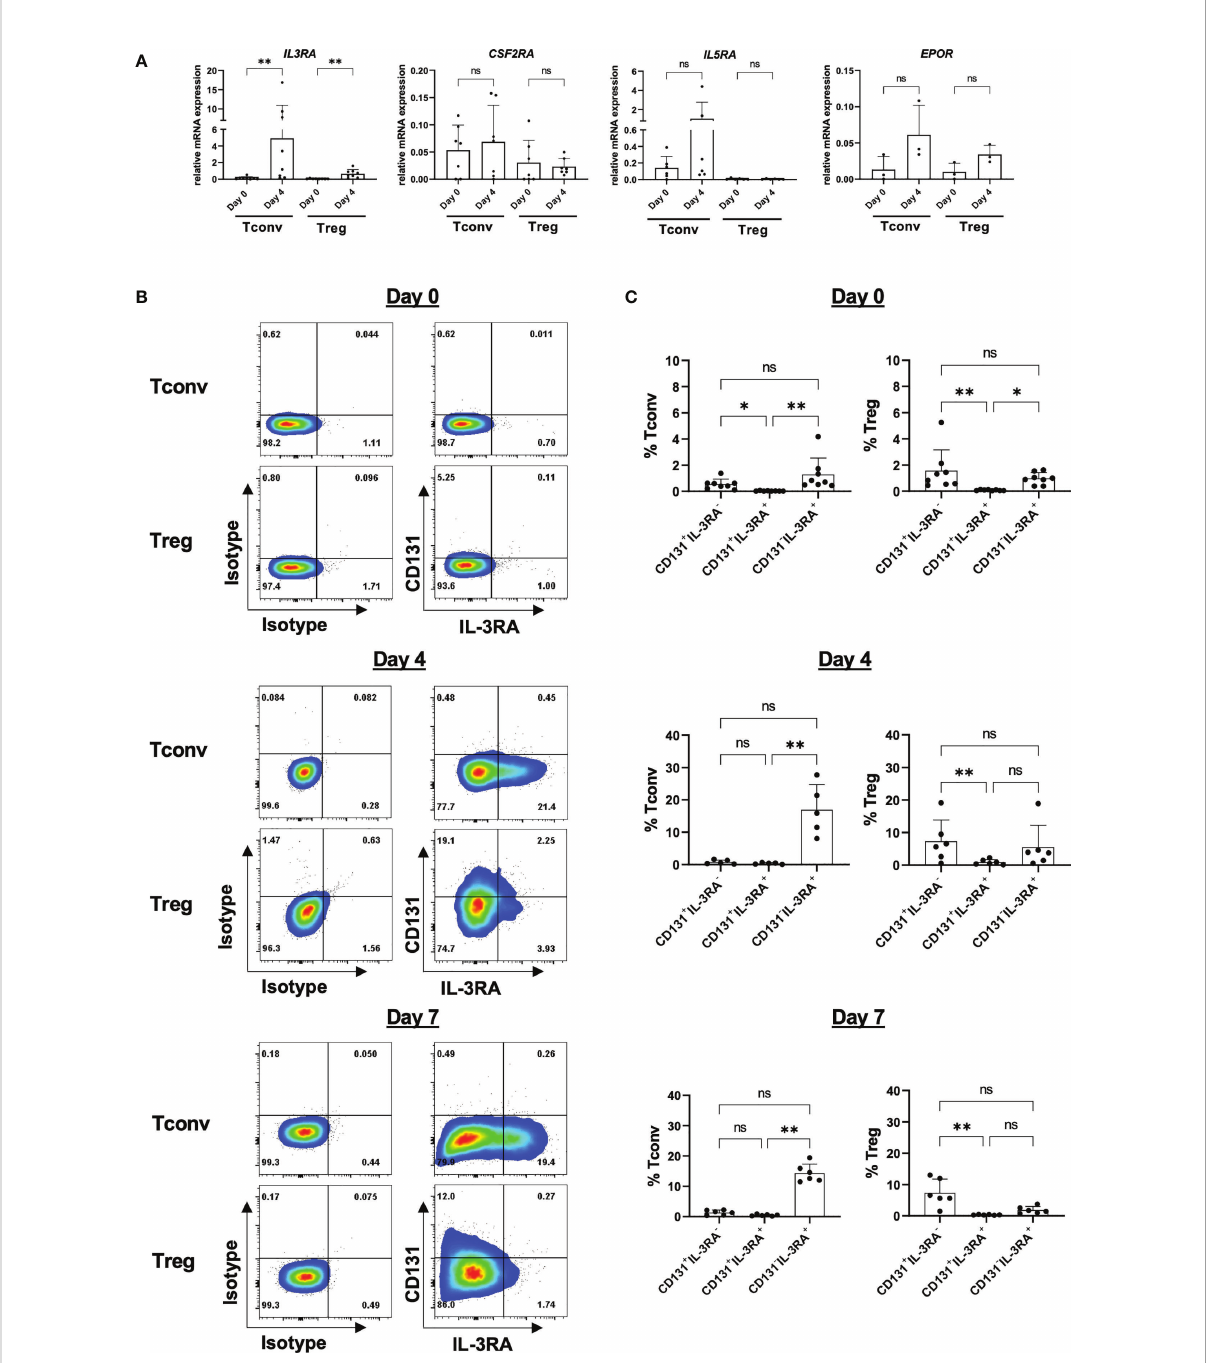
FIGURE 4 Expression of CD131-associated cytokine receptors on CD4 + Tconv and Treg populations. CD4 + CD25 - CD127 + Tconv and CD4 + CD25 + CD127 - Treg cells were fl ow-sorted from human PBMCs and stimulated in vitro with 1-10µg/ml anti-CD3 mAb, 1µg/ml anti-CD28 mAb and 25-300U/ ml IL-2. (A) mRNA expression levels of IL-3 receptor alpha ( IL3RA ), GM-CSF receptor alpha ( CSF2RA ), IL-5 receptor alpha ( IL5RA ) and EPO receptor ( EPOR ) chains were studied in CD4 + CD25 - CD127 + Tconvs and CD4 + CD25 + CD127 - Tregs prior (day 0) and after 4 days of in vitro - stimulation (day 4). Relative mRNA levels were normalized to the expression of B2M mRNA (n=3-8 independent donors). (B) IL-3RA and CD131 surface protein expression were studied in CD4 + CD25 - CD127 + Tconvs and CD4 + CD25 + CD127 - Tregs prior (day 0) and after 4 or 7 days of in vitro -stimulation. One representative donor is shown. (C) Cumulative data from 5-8 independent donors. Mean ± SD is shown. Signi fi cance was calculated using a Friedman test with Dunn ’ s multiple comparisons test. ns for P > 0.05, * for P ≤ 0.05, ** for P ≤